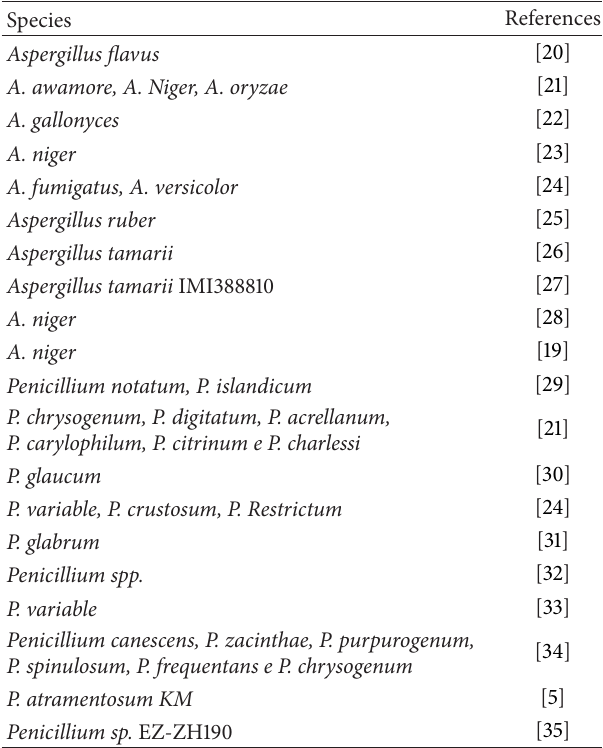
Table1:Speciesof Aspergillus and Penicillium reportedasproducing tannase between the years 1968 and